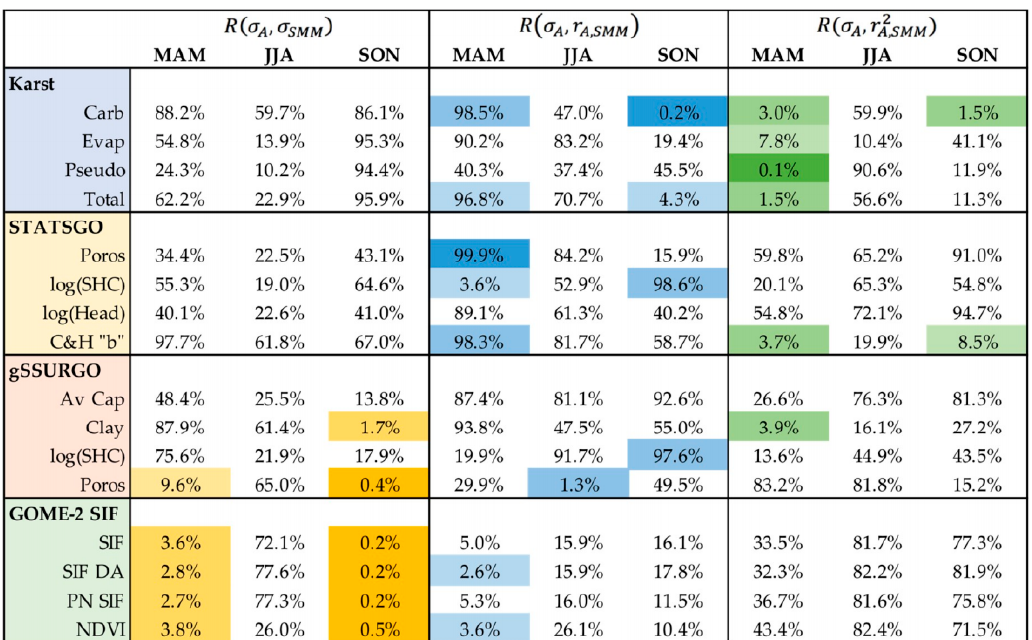
Figure 4, reversal of sign of the correlation r A , SMM in R ( σ A , r A , SMM ) between spring and fall for SMM correspondence to karst and to saturated hydraulic conductivity (SHC). Hydrology 2018 , 5 , x FOR PEER REVIEW